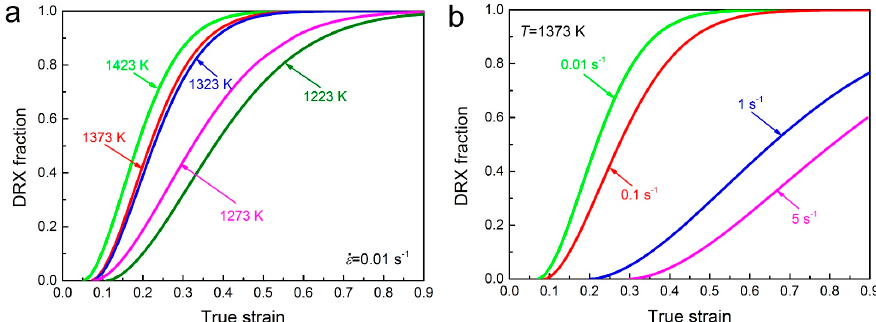
Figure 11. Volume fractions of dynamic recrystallization (DRX) obtained at ( a ) different temperatures with the strain rate of 0.01 s − 1 and ( b ) different strain rates with the temperature of 1373 K. To evaluate the precision of the developed DRX model, the metallographic observation is performed under typical conditions and the microstructures obtained at 1373 K and 0.1 s − 1 with low strains are shown in Figure 12. It can be seen that the DRX volume fraction indeed increases as the strain increases, and the values at strains of 0.162 and 0.357 are about 12% and 65%, respectively. More comparisons between the experimental and the predicted data have been carried out, as shown in Figure 13. As is seen, the predicted DRX volume fractions (the plots) agree well with the experimental ones (the points). The calculated value of R is 0.985 (Figure 13 inset), which confirms that the model can be applied to predict the volume fraction of DRX for 70MnSiCrMo carbide-free bainitic steel in a hot working process with good precision.